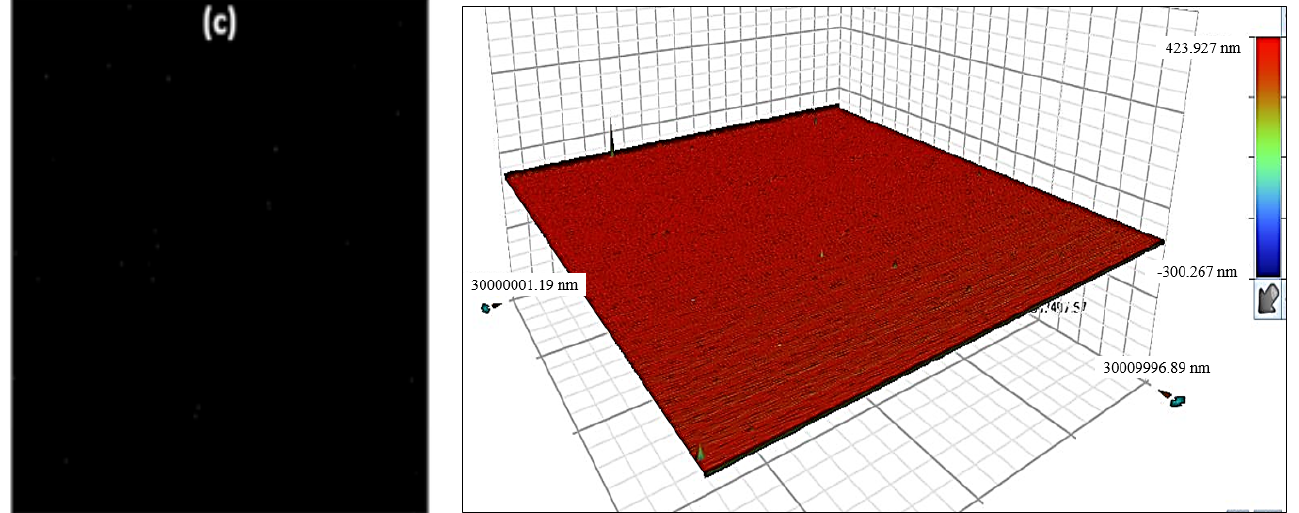
Figure 16. 1D and 3D surface profile of coated intact samples; ( a ) initial; ( b ) after 48 h of HAST test; ( c ) after 170 h of SUN test.